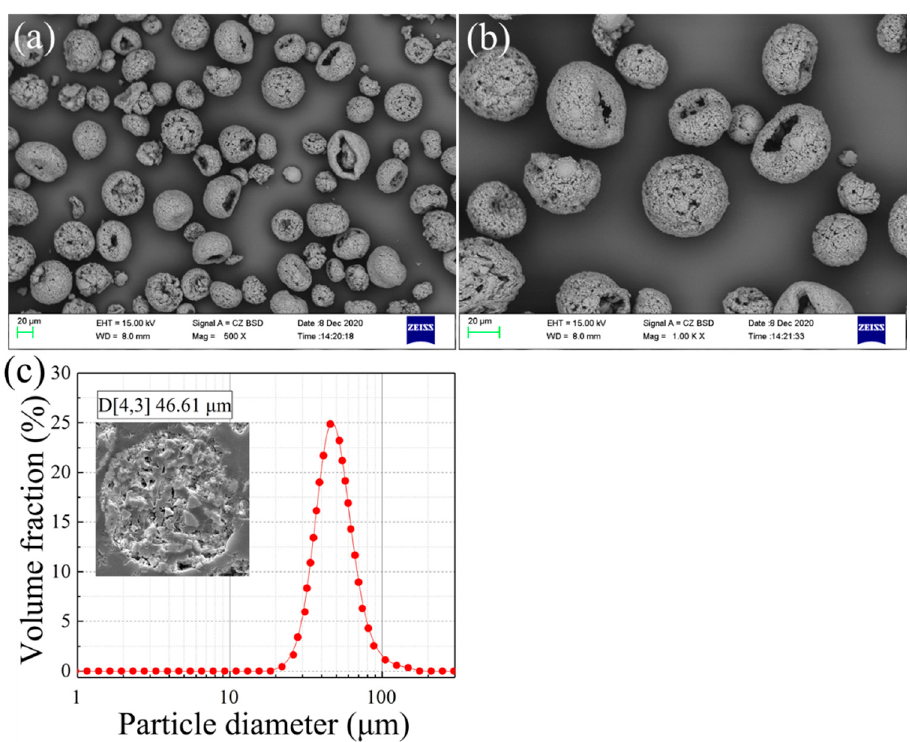
Figure 1. Morphologies of micro-agglomerated particles with particle sizes of 15–45 µm employed for the deposition of top coatings. ( a ) Low-magnification images of the microstructure. ( b ) High-magnification images of the microstructure and ( c ) size distribution.